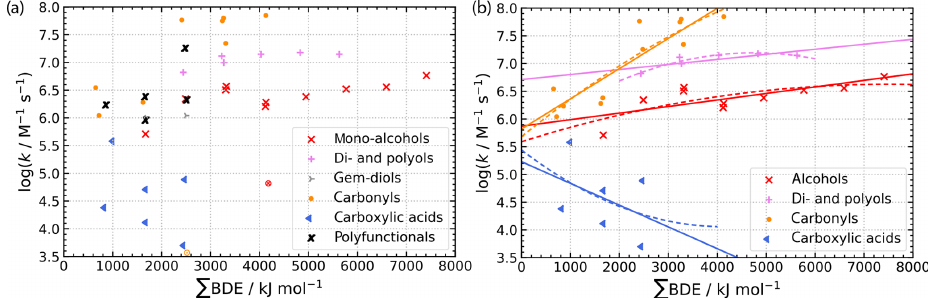
Figure 7. Experimental second-order rate constants versus accumulated bond dissociation enthalpies of all bonds in molecules containing H atoms ( (cid:54) BDE). Panel (a) shows the raw data and panel (b) the final datasets of the combined compound classes and their linear and quadratic